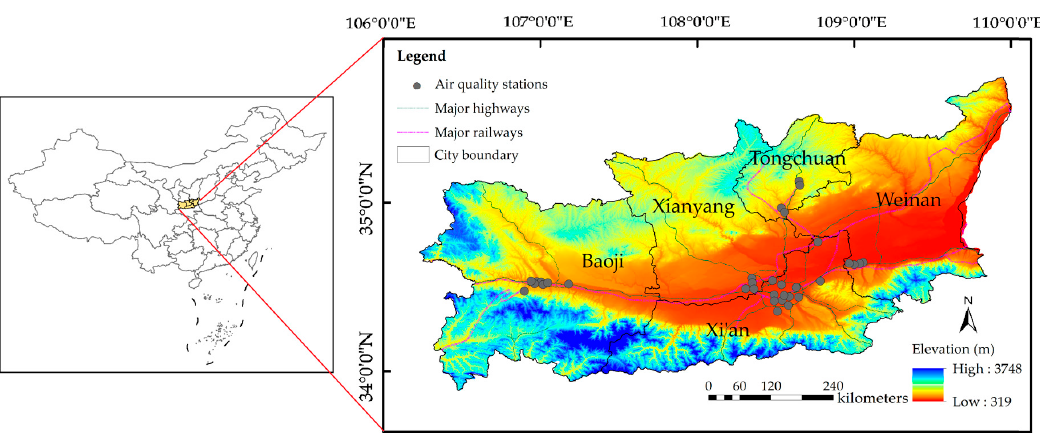
Figure 1. Elevation map of the Guanzhong Basin and its location in China. The map shows the five major cities, major highways, major railways and the locations of air quality monitoring stations in the study area.